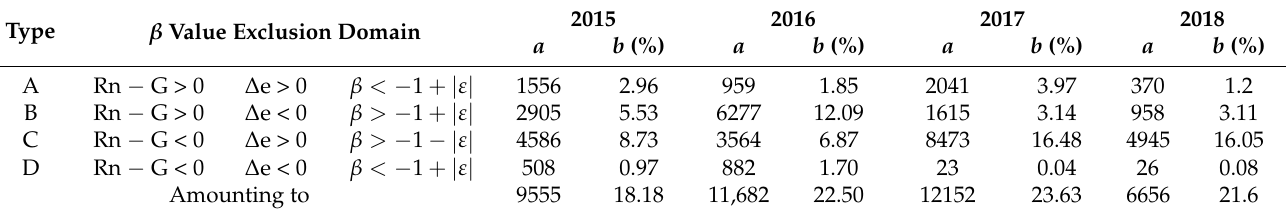
Table 4. β value rejection domain types and data disqualification